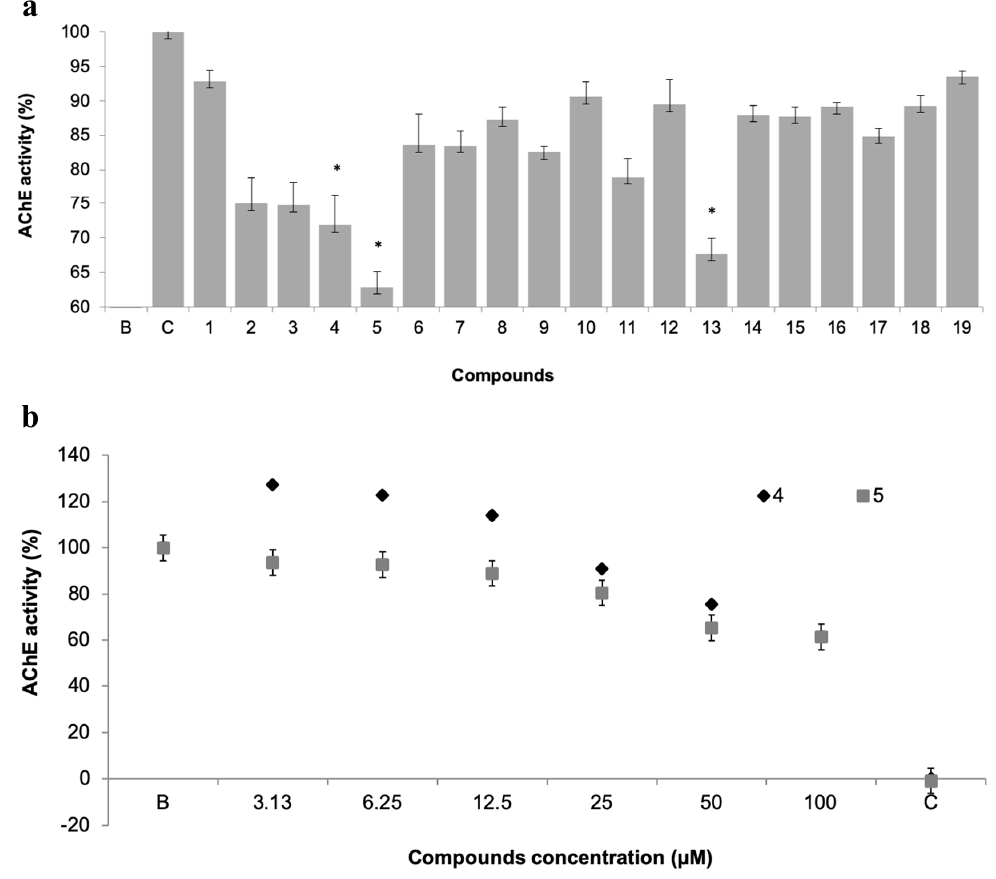
Figure 4. ( a ) Acetylcholinesterases (AChE) activity of 19 pure xanthones (50 µ M). * significant di ff erences ( p ≤ 0.05, Dunnett’s test) compared to the negative control (B); eserine was used as positive control (C). ( b ) Dose-response of AChE activity of selected xanthones 4 and 5 .